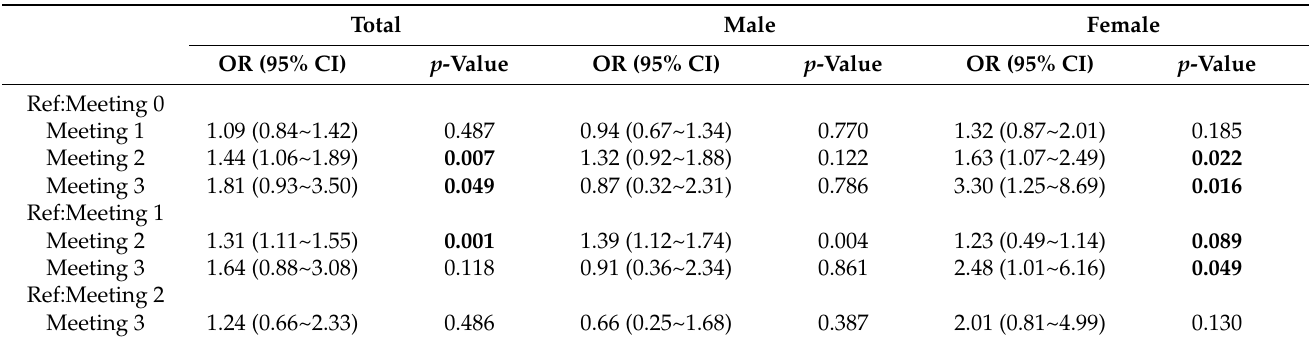
Table 2. The relationship between the number of 24-HMG recommendations met and mental health in the sample.